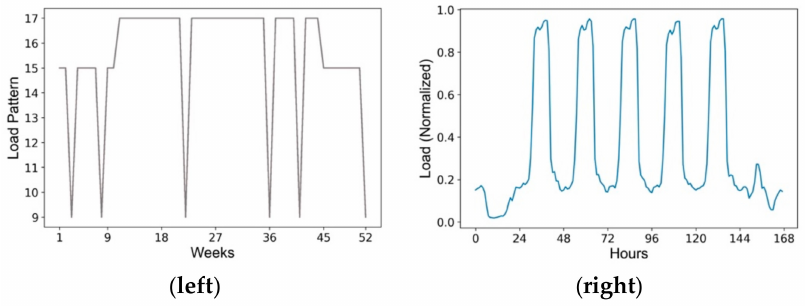
Figure 12. Typical user behaviors of Warehouse ( left ) and corresponding load patterns in short-term ( right ).